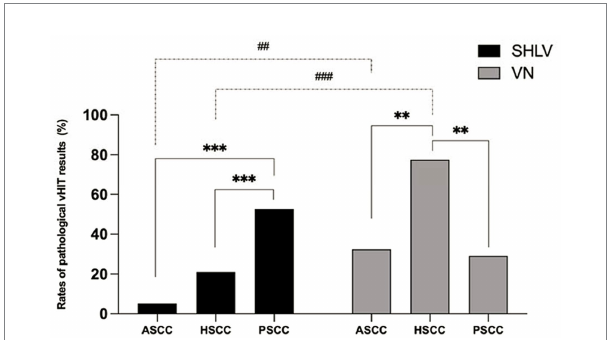
FIGURE 1 Comparison between the incidences of pathological video head impulse test (vHIT) results of anterior semicircular canal (ASCC), horizontal semicircular canal (HSCC) and posterior semicircular canal (PSCC) on the affected sides in sudden sensorineural hearing loss with vertigo (SHLV) patients and vestibular neuritis (VN) patients. ** p < 0.01, *** p < 0.001, ## p < 0.01, ### p < 0.001. Dotted line: comparison between SHLV and VN group. Solid line: comparison between three semicircular canals (SCCs) within SHLV or VN group.